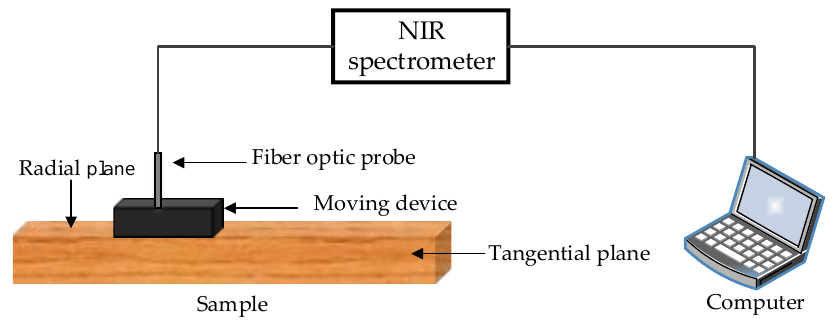
Figure 1. The diagram of spectra measurements.